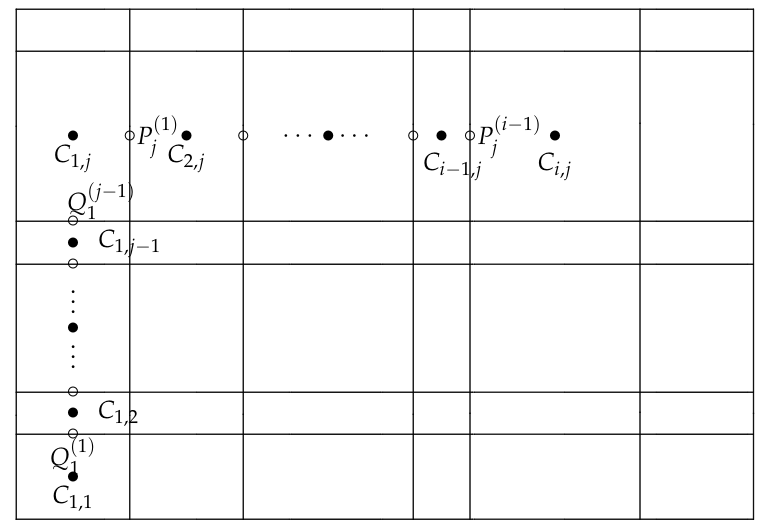
Figure 4. Example of path reconstruction in the first subdomain to get C i , j starting from C 1,1